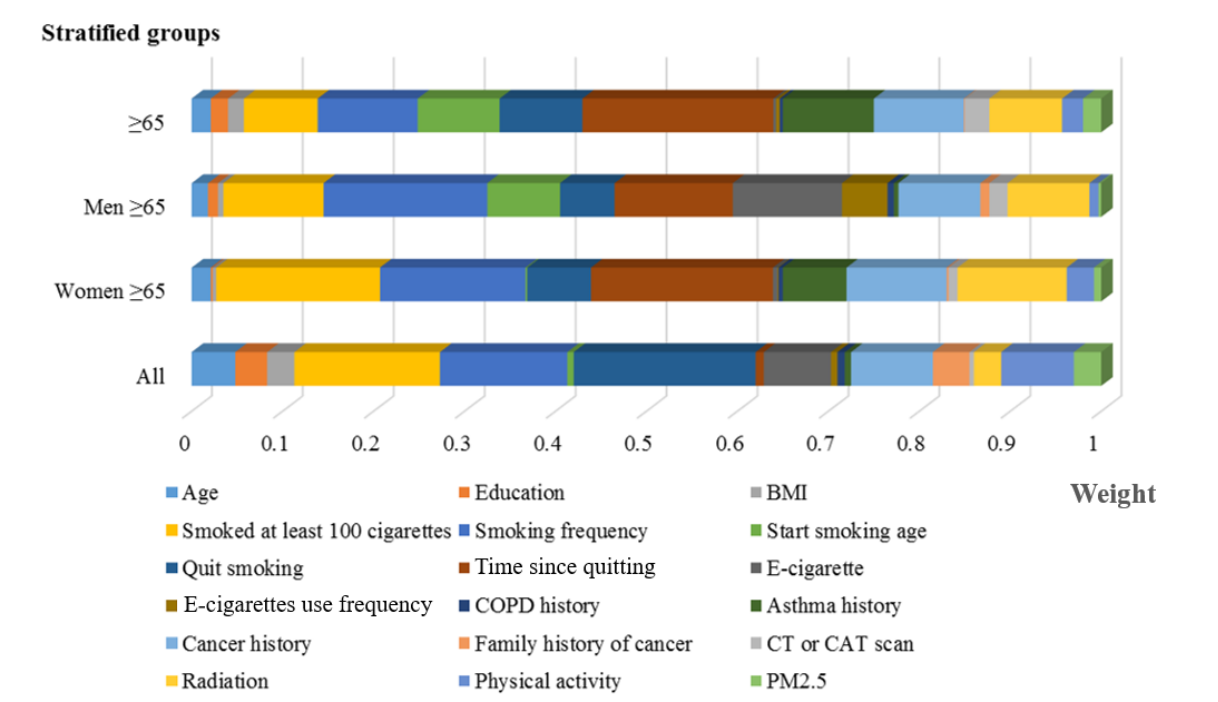
Figure 5. Normalized weights of risk factors in the stratified groups. BMI: body mass index; CAT: computerized axial tomography; COPD: chronic obstructive pulmonary disease; CT: computed tomography; PM2.5: fine particulate matter with a diameter ≤ 2.5